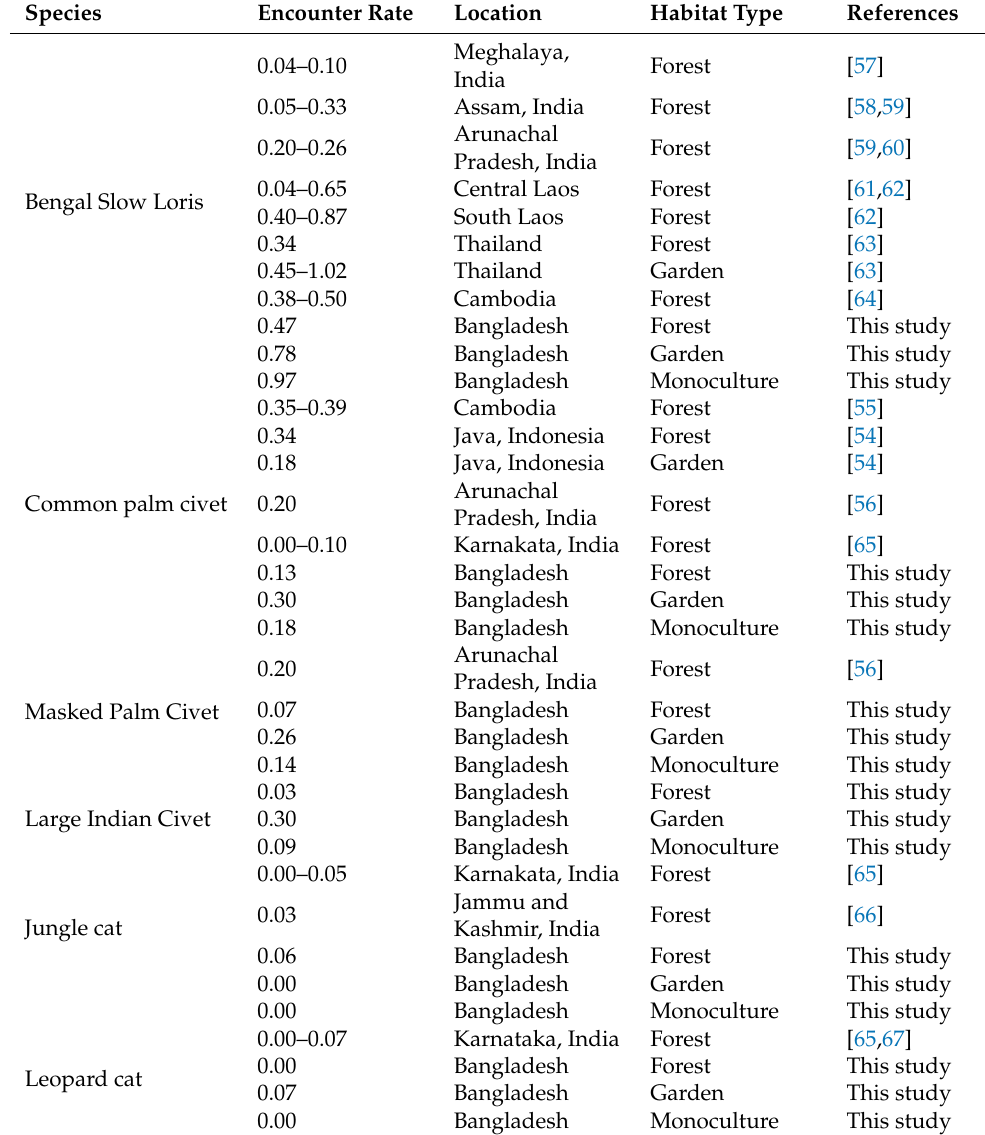
Table 4. Encounter rates of the species surveyed in Bangladesh and comparison with other sites where the species is present. This table is for general comparison only since variance at each site is unknown or not